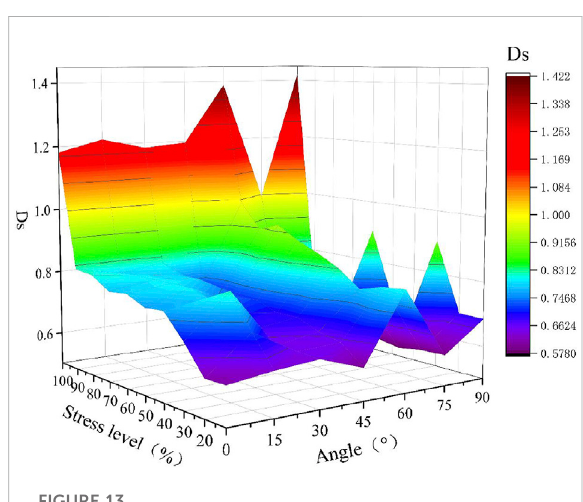
FIGURE 13 Plot of stress level versus fractal dimension Ds for different natural crack inclination